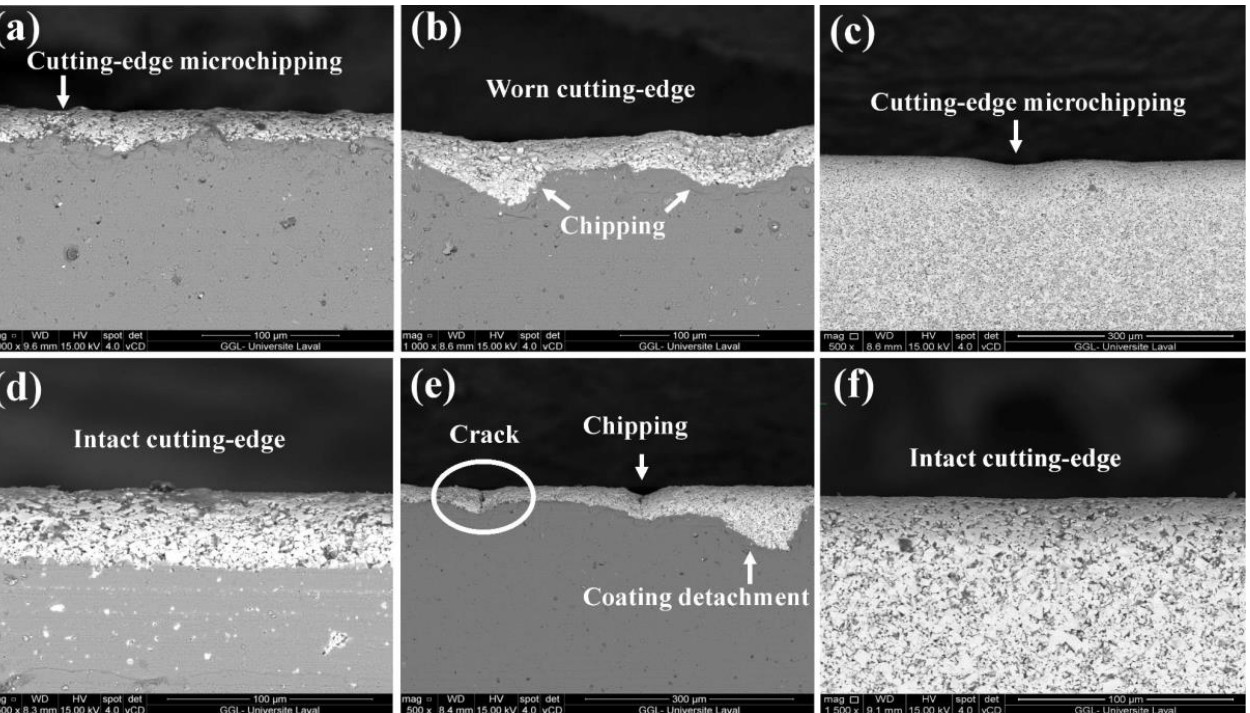
Figure 24. Typical aspect of the cutting edge of tips (rake face view): ( a , d ) saws #2, ( b , e ) saws #4, and ( c , f ) saws #6 after 480 min of sawing.